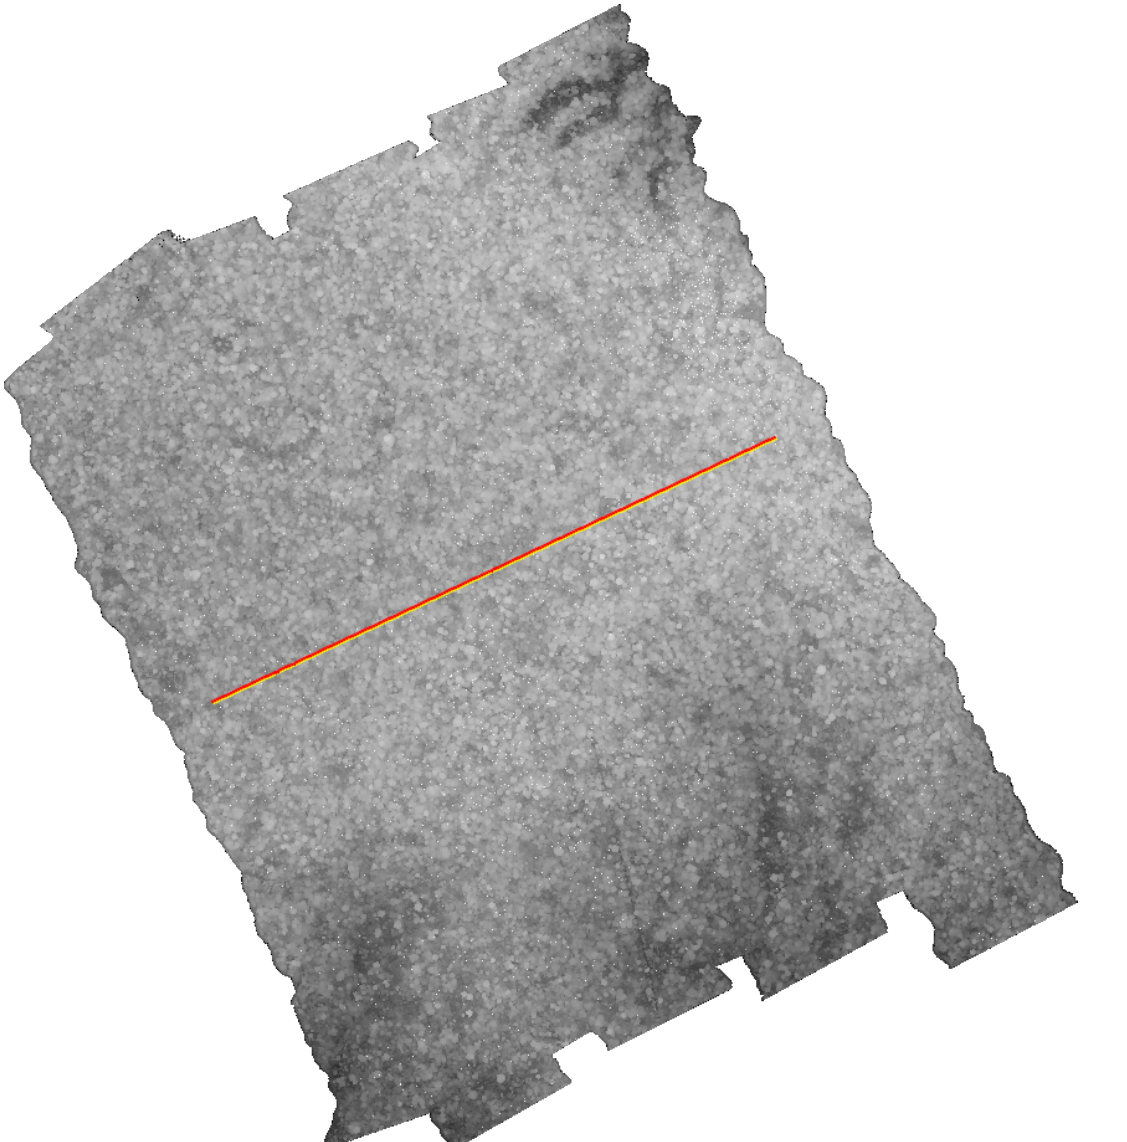
Figure 16. Trajectory in yellow on surface, square bin, experiment. Corresponding estimated positions are drawn in